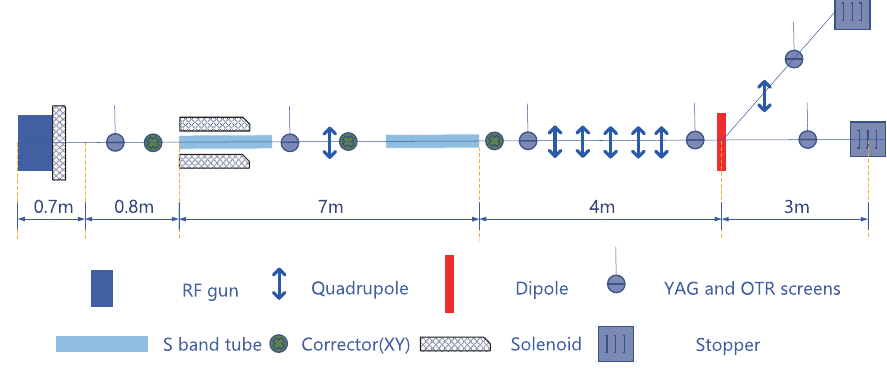
FIG. 1. Layout of the XGLS